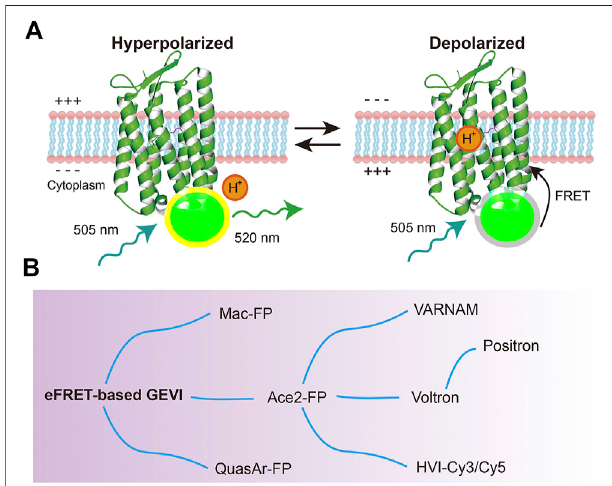
FIGURE 3 | eFRET-based GEVIs. (A) Voltage sensing mechanism of eFRET-based GEVIs (Ace2N-mNeon). At a depolarized stage, the Schiff base of microbial rhodopsin is protonated, and the absorbance of rhodopsin changes. This absorption quenches the fl uorescence of the appended fl uorescent proteins or other bright fl uorophores. (B) Evolution of eFRET- based